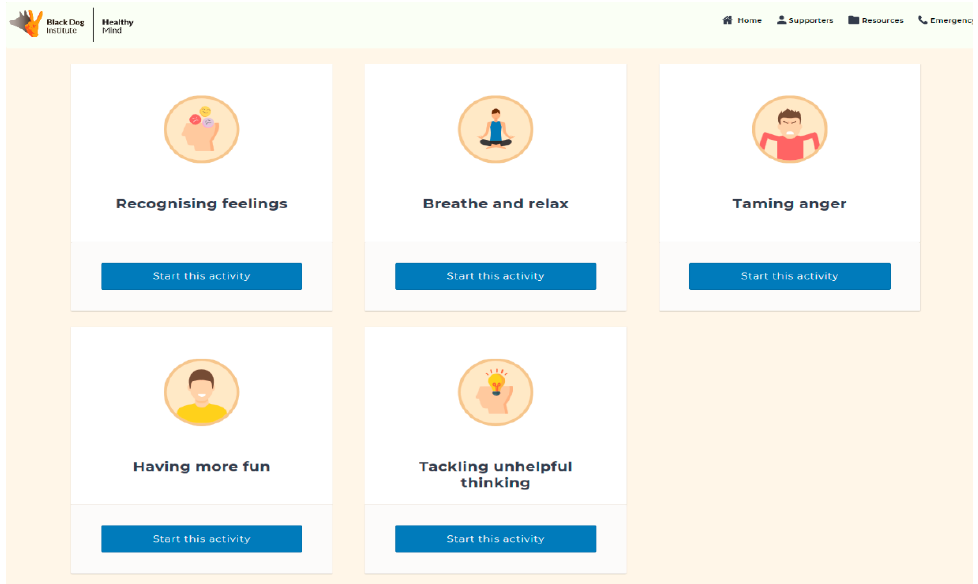
Figure 3. Screenshot of Healthy Mind “Breathe and relax” activity.